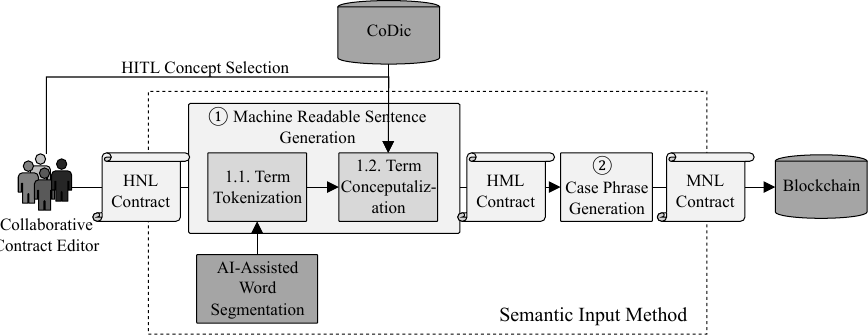
Figure 1. The structure of the AIASCG